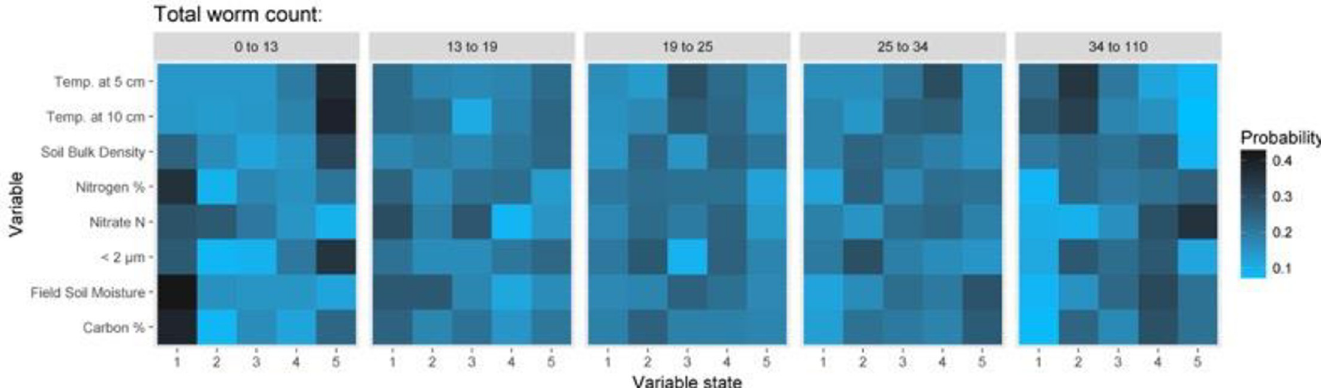
Fig 3. Panels show the sensitivity of the overall Bayesian belief network to main continuous variables used to predict values of total earthworm counts across all 7 farms. Values of the continuous variables were split into 5 bins (where Bin 1 has the lowest values and 5 the highest) as defined for this dataset. For details of bin ranges see Table 1; the more intense the colour the more likely this value is for this number of earthworms. For example, at a depth of 5 cm, if temperature is in the range 12– 16˚C then earthworm abundance is most likely to be low (0–13 individuals), if the observed temperature is in the range 9.1–10.8˚C, then the earthworm abundance will probably be in the range of 25–34 individuals, and at an observed temperature range 6.9–9.1˚C then the abundance is most likely to be high (34–110 individuals), at a farm